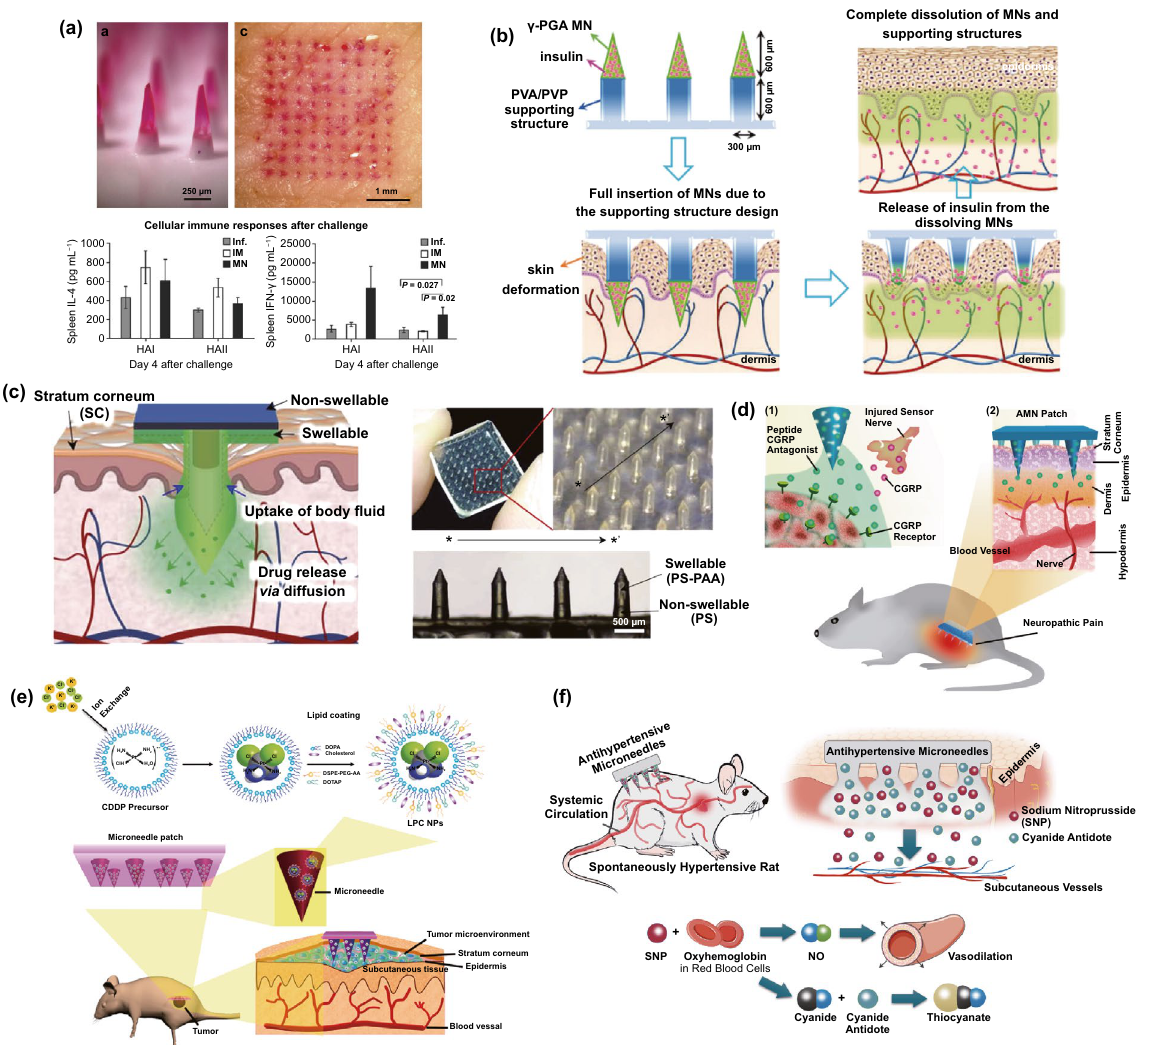
Fig. 10 Water‑soluble or biodegradable microneedles used for hypodermic formation delivery. a Dissolvable microneedle delivered inactivated influenza virus and achieved effective vaccinations compared with traditional intramuscular immune (i.m.) immunization [214]. b Schematic diagram of insulin delivery by microneedle composed of poly γ ‑glutamate (γ‑PGA) and PVA/PVP [216]. c Swellable microneedles used for prolonged release of insulin [218]. d Longer hypoglycemic effect than subcutaneous injection demonstrated in diabetic rats, using gelatin com‑ posites microneedles for slow drug releasing [219, 220]. e Schematics of delivering CGRP antagonist peptide for curing localized neuropathic pain via dissolvable MNs [221]. f Cisplatin loaded microneedles were employed for safe and efficient antitumor therapy [222]. g Biodegradable microneedle used for combinative delivery of SNP and sodium thiosulfate via biodegradable microneedles for side effects controlled antihyper‑ tensive therapy [223]. Reproduced with permission from Refs. [214, 216, 218–223], copyright (2010) Nature Publishing Group, (2018)